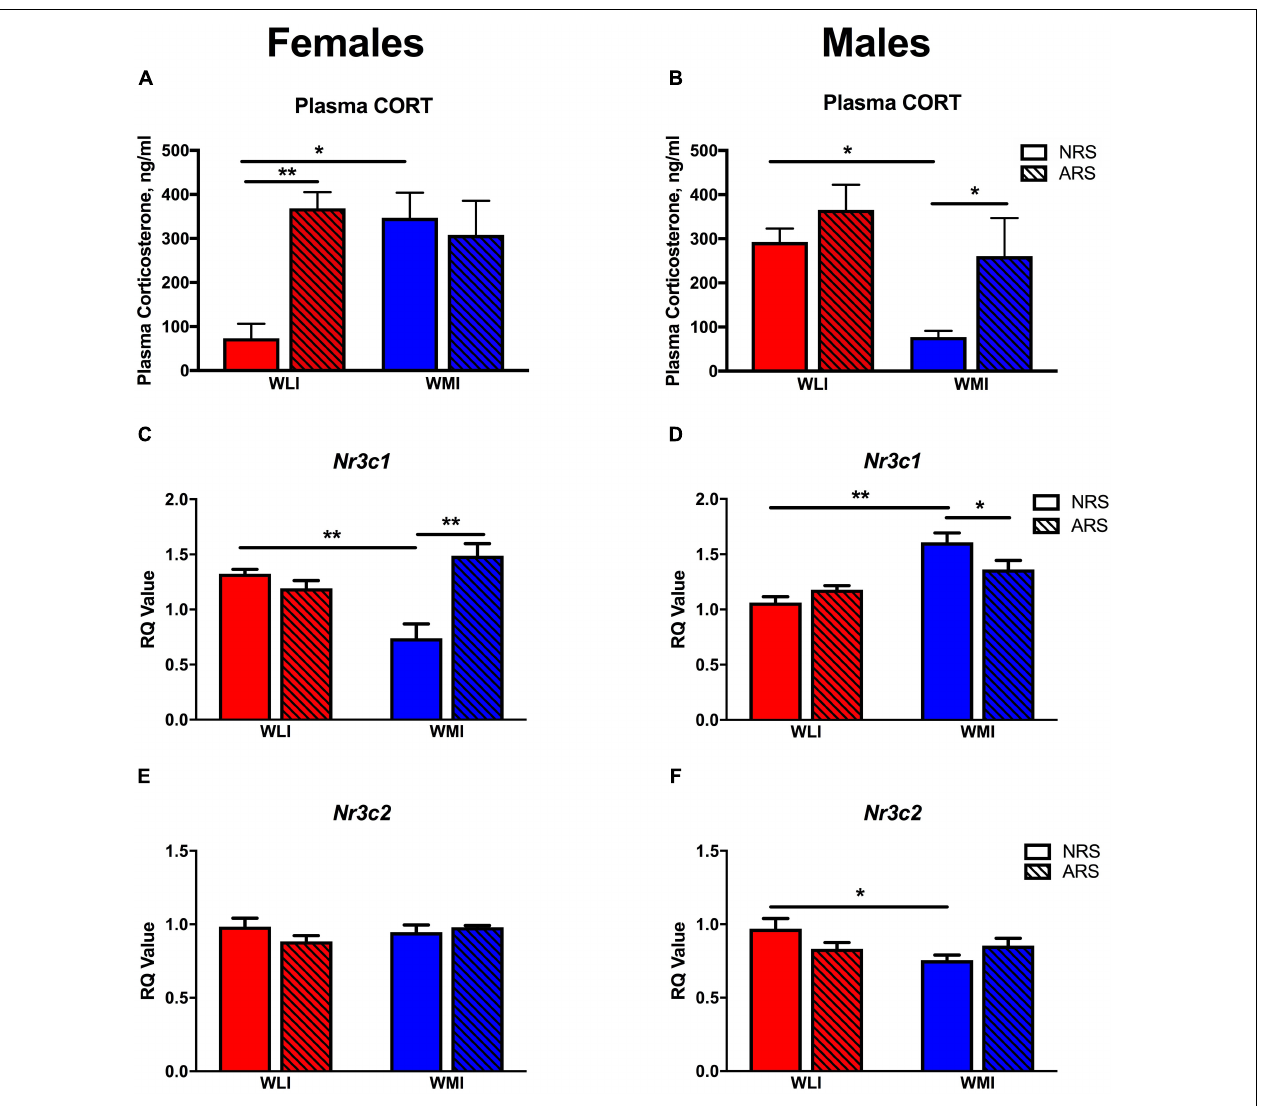
FIGURE 3 | Plasma corticosterone and hippocampal glucocorticoid and mineralcorticoid receptor expression. CORT levels were significantly higher in NRS WMI females (A) and NRS WLI males (B) compared to the other strain. Acute restraint stress resulted significantly higher CORT levels in the WLI females and WMI males compared to their NRS counterparts (A , B) , respectively. Hippocampal Nr3c1 transcript levels showed the opposite pattern to that of plasma CORT. Nr3c1 expression is decreased in the NRS WMI female (C) and in the NRS WLI male (D) compared to the other strain in the NRS condition. Acute stress increased Nr3c1 expression in the WMI female but decreased it in the male hippocampus (C , D) , respectively. Hippocampal Nr3c2 transcript levels showed no significant differences in females (E) , but decreased expression in NRS WMI compared to NRS WLI (F) . Plasma CORT levels, were measured by ELISA, in samples collected 48 h after the restrain stress or no stress applied. Transcript levels were measured in the hippocampus collected at the same time. The RT-PCR used GAPDH as the housekeeping gene and a general calibrator. Relative quantification (RQ) employed the 2 − (cid:49)(cid:49) Ct method. Values are shown as mean ± SEM; ∗ p < 0.05; ∗∗ p < 0.01. NRS, no stress; ARS, acute restraint stress; CORT, corticosterone; Nr3c1 , glucocorticoid receptor; Nr3c2 , mineralcorticoid receptor. WLI NRS male n = 5(CORT), 4( Nr3c1 ), 6( Nr3c2 ); NRS female n = 6(CORT), 5( Nr3c1 ), 8( Nr3c2 ); ARS male n = 4(CORT), 5( Nr3c1 ), 5( Nr3c2 ); ARS female n = 6(CORT), 6( Nr3c1 ), 6( Nr3c2 ); WMI NRS male n = 5(CORT), 4( Nr3c1 ), 6( Nr3c2 ); NRS female n = 4(CORT), 4( Nr3c1 ), 8( Nr3c2 ); ARS male n = 4(CORT), 5( Nr3c1 ), 5( Nr3c2 ); ARS female n = 6(CORT), 6( Nr3c1 ), 6( Nr3c2